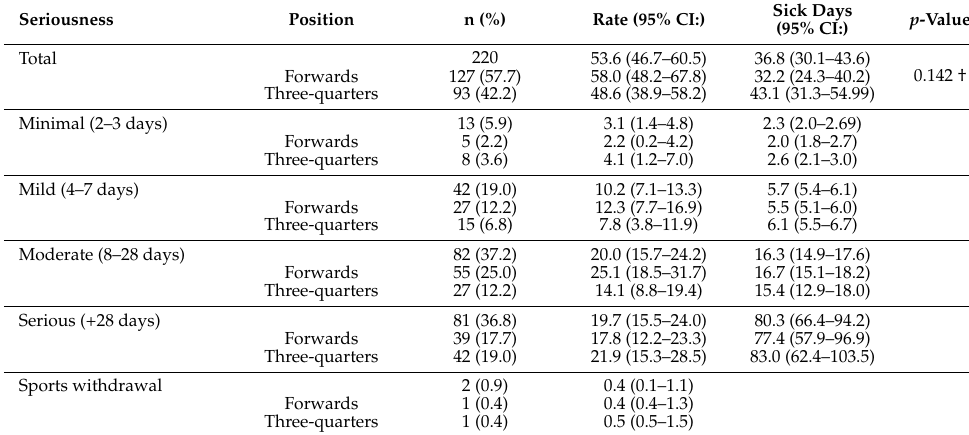
Table 2. Seriousness of the